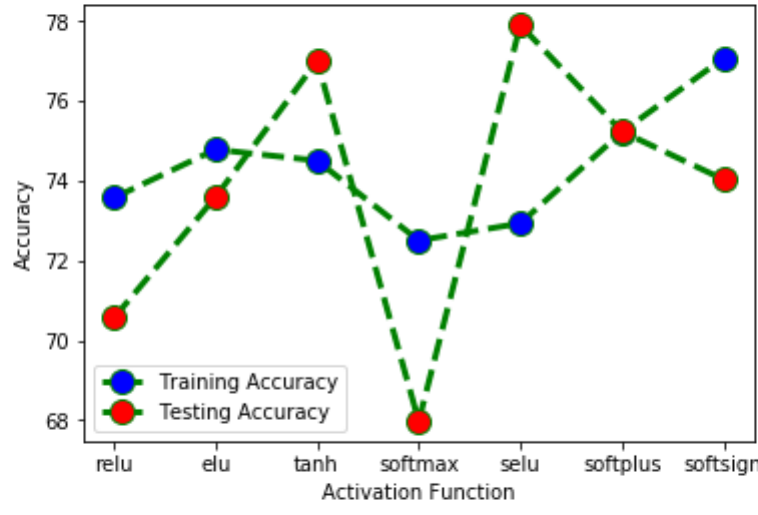
Figure 2. Performance Evaluation of Activation Functions